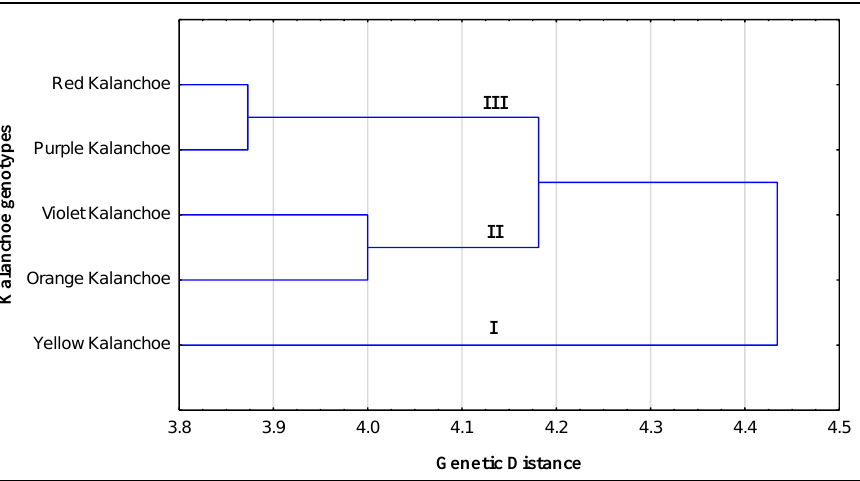
Figure 5. Phylogenetic tree of five kalanchoe genotypes revealed by the weighted pair group method using arithmetic average (WPGMA) method based on SCoT, ISSR and RAPD banding patterns.